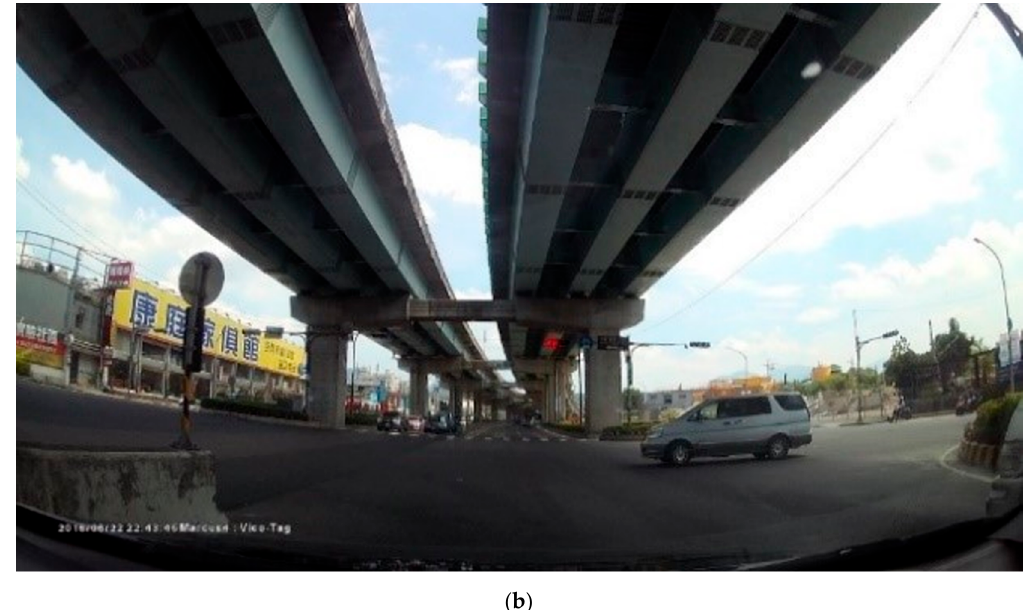
Figure 8. Our car detection model training data set. We show the data set in two rows: ( a , b ) are the data set we used in car detection.